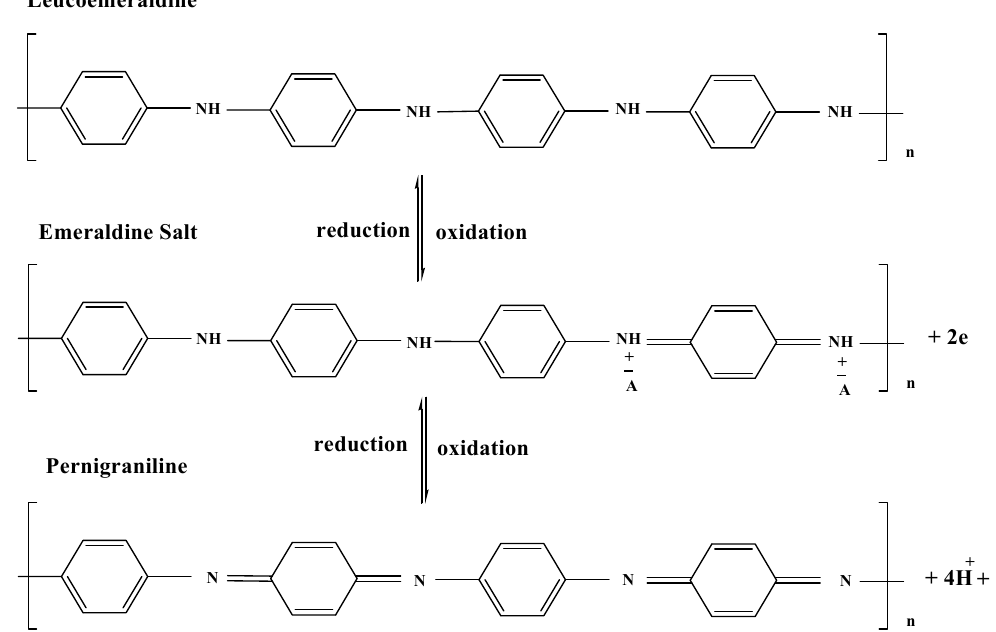
Figure 2. Fourier-transform infrared spectroscopy (FTIR) spectrum of the synthesized PANI. The benzenoid and quinoid stretching is denoted by the peaks at 1492 cm -1 and 1552 cm -1 , respectively [33]. The polaron C–N* stretching is located at 1299 cm -1 indicating the conducting form of PANI [34]. The peak at 1110 cm -1 is attributed to the stretching of C–N= [35,36] while the peak at 808 cm -1 shows out of plane deformation of C–H [37]. The aliphatic C–H, due to DBSA, is represented by the bands at 2825–2911 cm -1 . The HSO 4 ¯ peak at 651 cm − 1 proves the presence of acidic dopants in